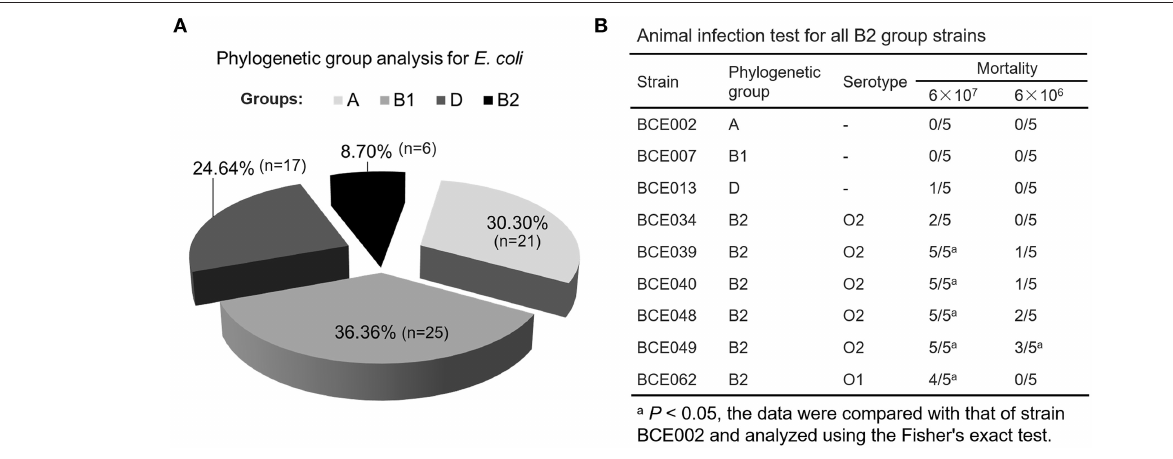
Frontiers in Veterinary Science |